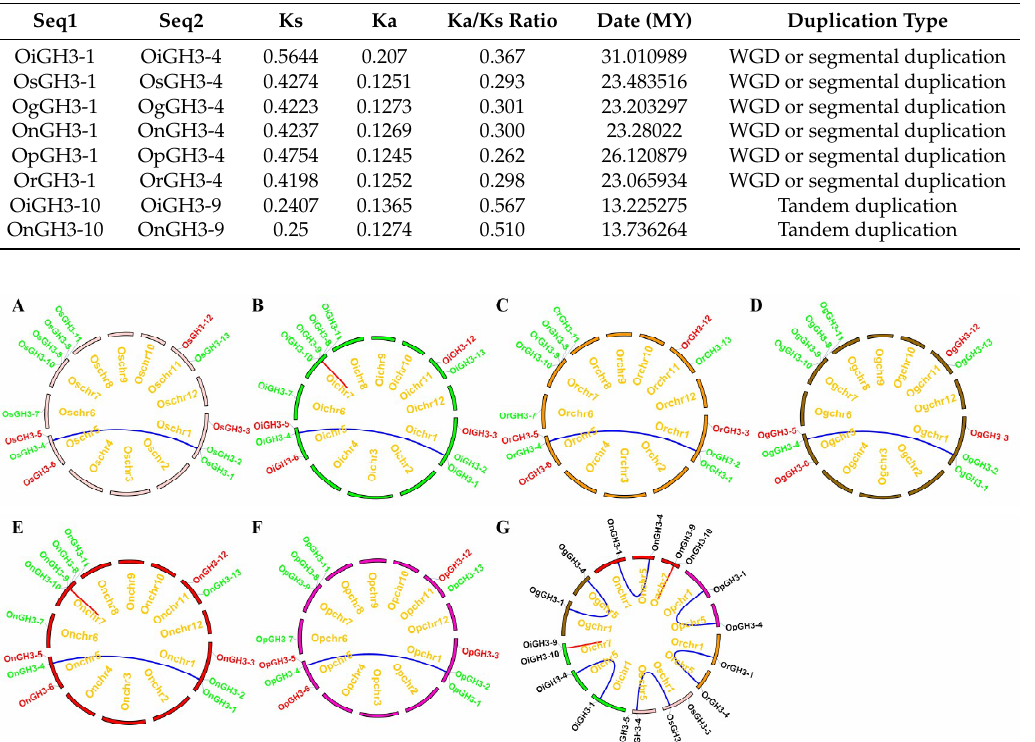
Table 2. Ka, Ks, and Ka/Ks values for the duplication gene pairs from six Oryza species/subspecies.